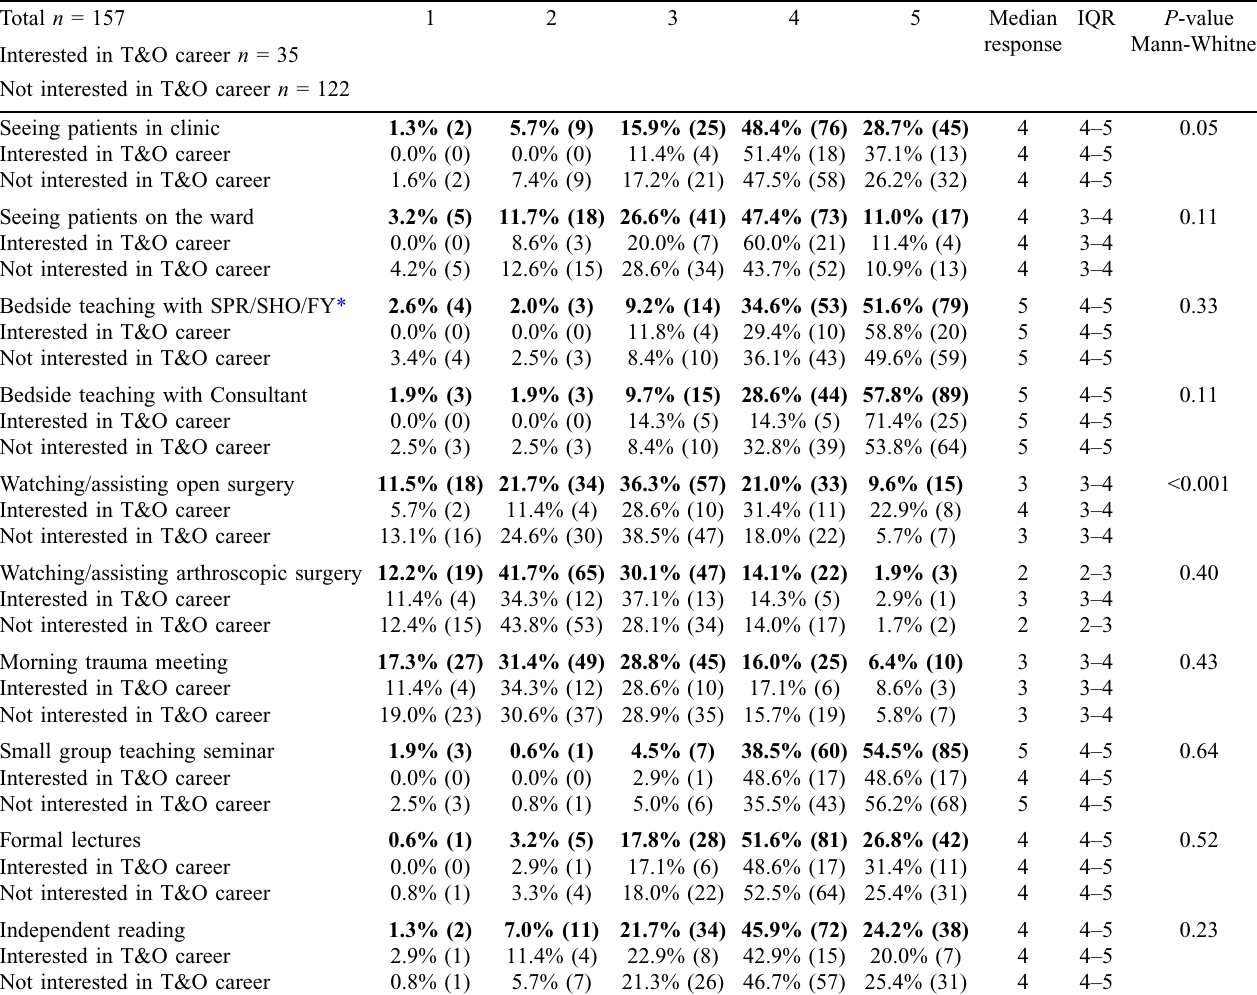
Table 1. Trauma and orthopaedic surgery student assessed educational value for each learning environment. Total n =